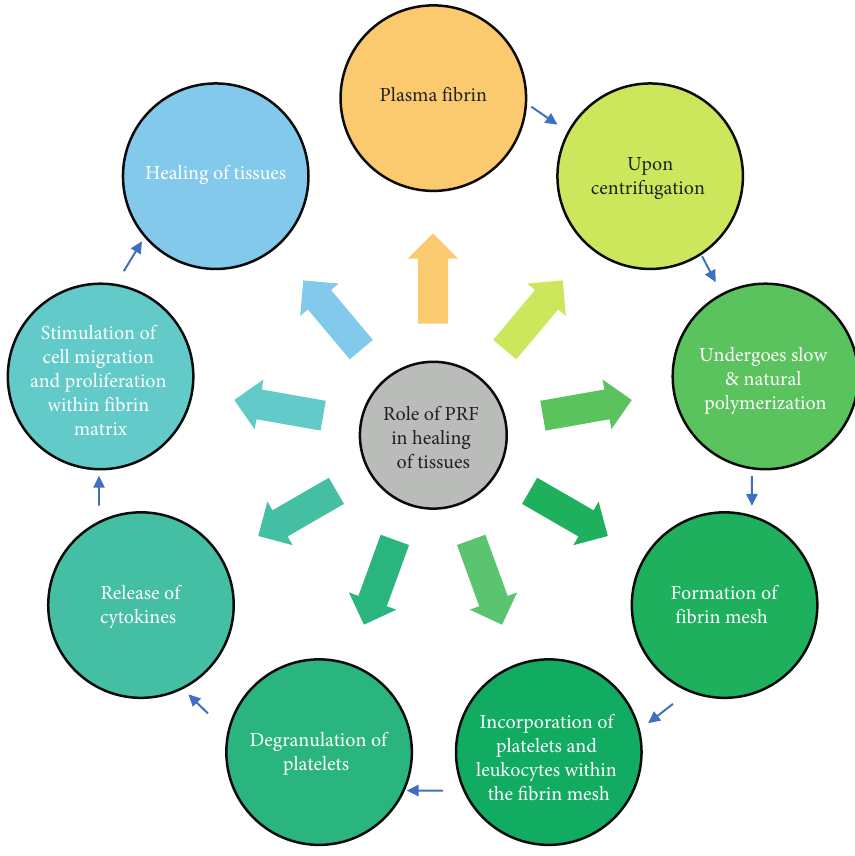
Figure 3: Role of PRF in healing of